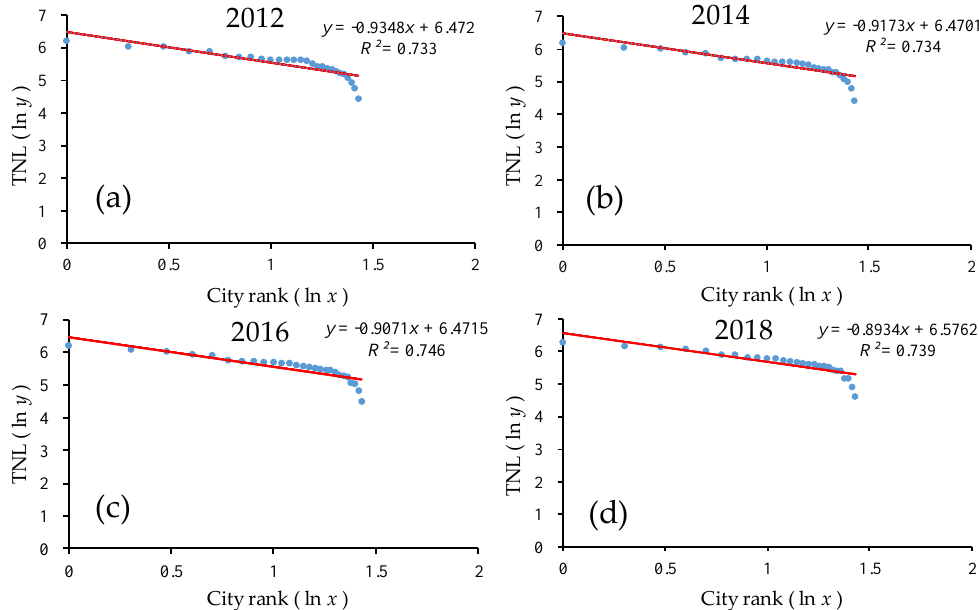
Figure 7. The ln–ln plot of the rank–size of the urban development for all provinces. Line regression of (a) TNL and ranking of all provinces in 2012; (b) TNL and ranking of all provinces in 2014; (c) TNL and ranking of all provinces in 2016; (d) TNL and ranking of all provinces in 2018. Table 2. Zipf’s law analysis at the provincial level in China from 2012 to 2018. All Provinces All Year